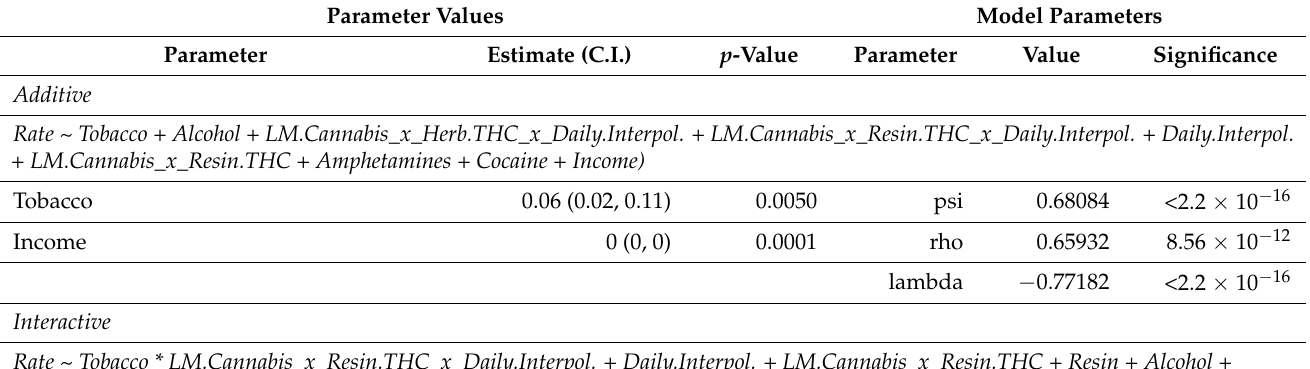
Table 2. Multivariate Geospatial Analysis for